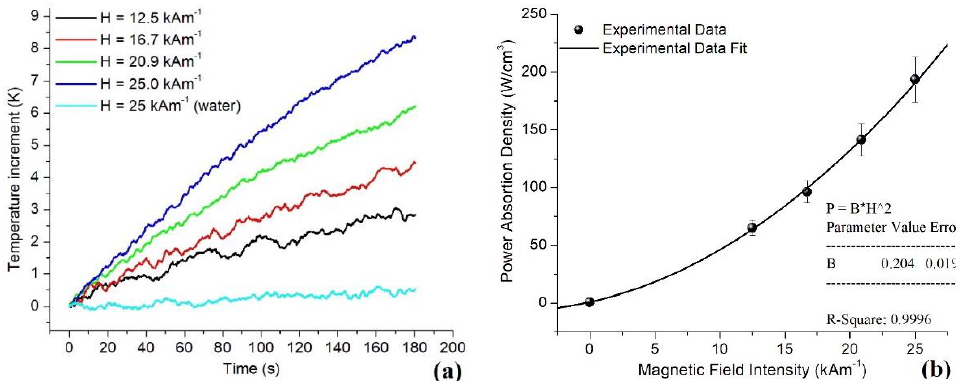
Figure 7. ( a ). Time dependence of the temperature rise of MNP-GA2, using several intensities of H over the interval 12.5 kAm − 1 < H < 25 kAm − 1 , with 4.17 kAm − 1 increments. One measurement at H = 25 kAm − 1 corresponds to a reference sample with 1 mL of pure water. ( b ) Estimation of P in W/cm 3 of the ferrofluid with MNP-GA2.